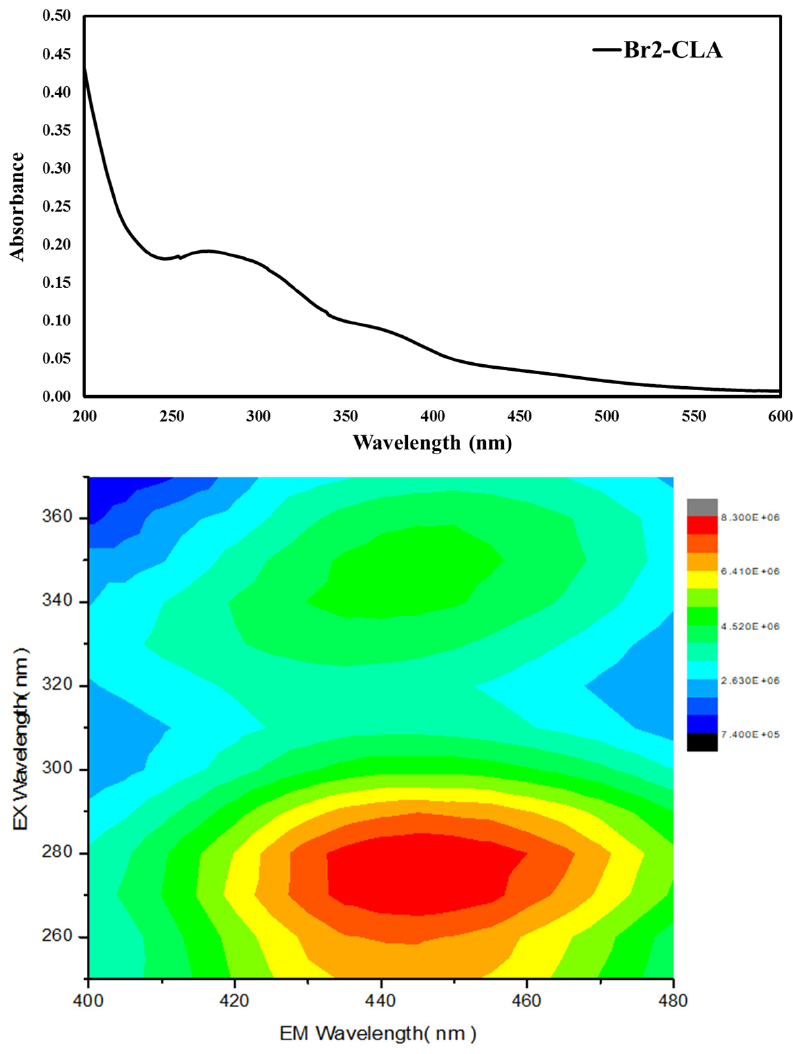
Figure 1. UV-Vis ( top ) and 2D EEM contour plot ( bottom ) for Br2-Cla (20 μ M) in aqueous solu- tion.